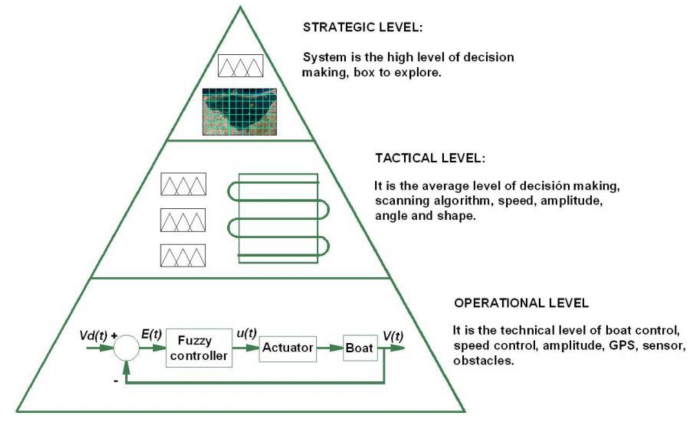
Figure 2. Hierarchical structure of the control system, showing the three levels of control: strategic, tactical and